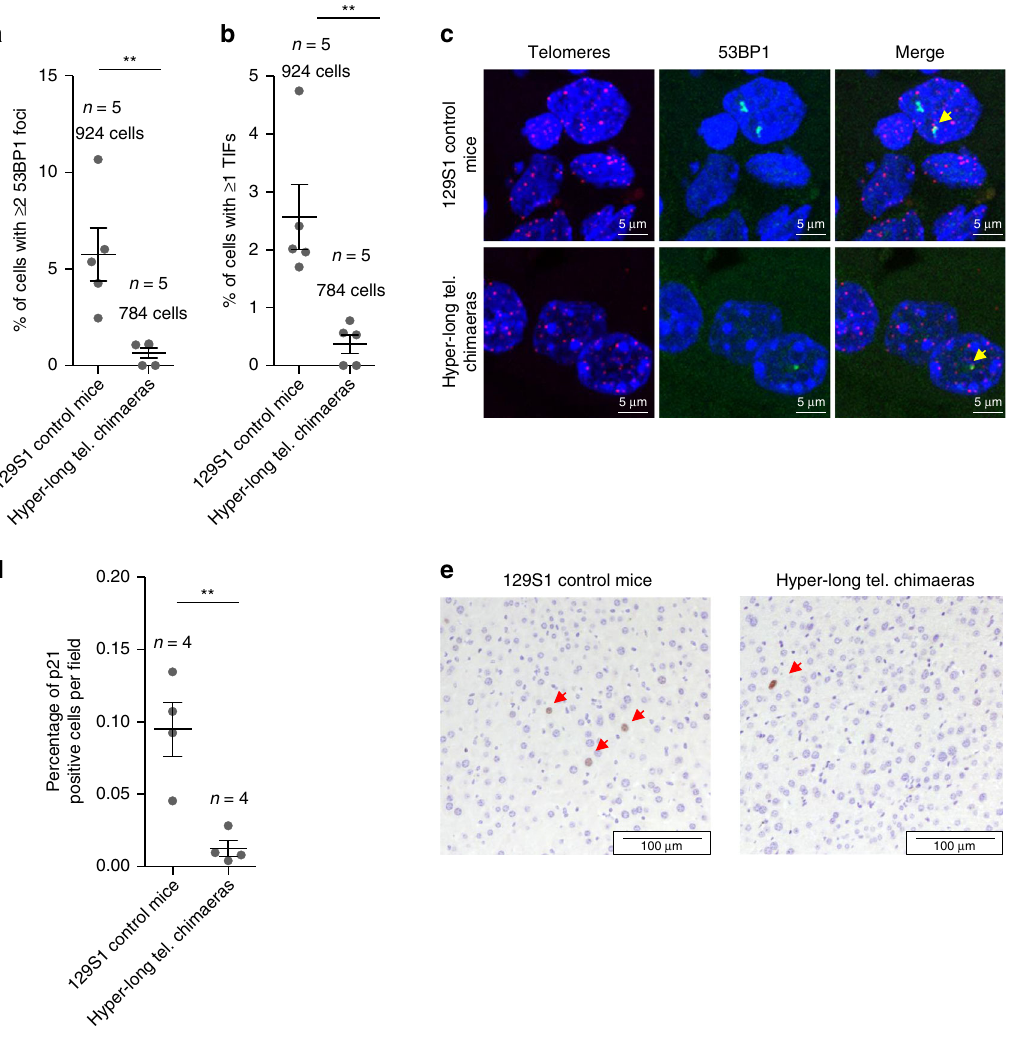
Fig. 8 Hyper-long telomere mice show less DNA damage and less senescence. a , b Quanti fi cation of DNA damage in age-matched (100 weeks old) hyper- long telomere mice and control mice. Quanti fi cation of total damage as indicated by percentage of cells with ≥ 2 53BP1 foci as determined by immuno fl uorescence ( a ) and quanti fi cation of cells showing telomere-induced DNA damage as shown by percentage of cells with ≥ 1 TIF (telomere induced foci) as determined by telomere FISH followed by immuno fl uorescence with 53BP1 antibody ( b ). c Representative images of TIFs (yellow arrow). d Quanti fi cation of the percentage of p21 positive cells in liver of age matched (100 weeks old) hyper-long telomere mice and control mice. e Representative images of p21 (red arrows) positive cells. Error bars represent standard error. t -test was used for statistical analysis. The number of mice is indicated in each case. ** p < 0.01. Source data are provided as a Source Data fi